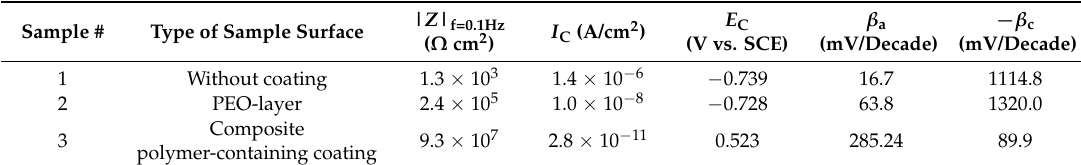
Figure 12. Polarization curves for the samples made of 1579 aluminium alloy (with welded joint area) without coating (the right one), with the PEO-coating (the middle one), and with the composite polymer-containing coating (the left one) obtained in 0.5 M NaCl solution. Table 2. Main electrochemical performances of the 1579 aluminium alloy (include welded joint area) samples with different treatment. Data were obtained by means of the potentiodynamic polarization and electrochemical impedance spectroscopy methods.